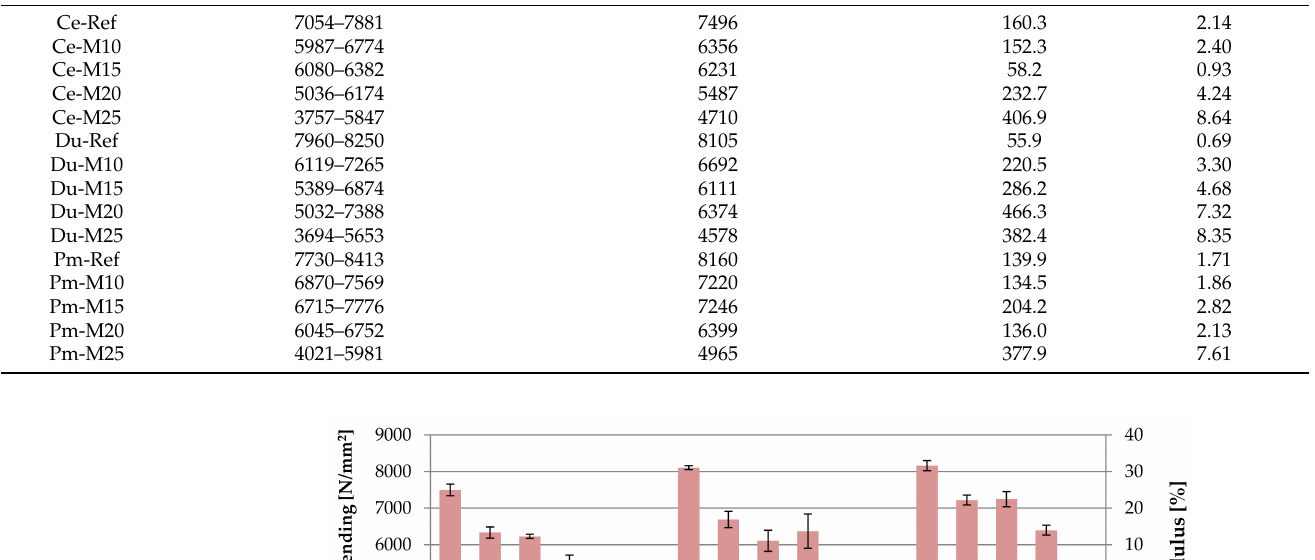
Table 5. Results of modulus of elasticity in bending testing of modified cement-bonded particleboards. Mixture